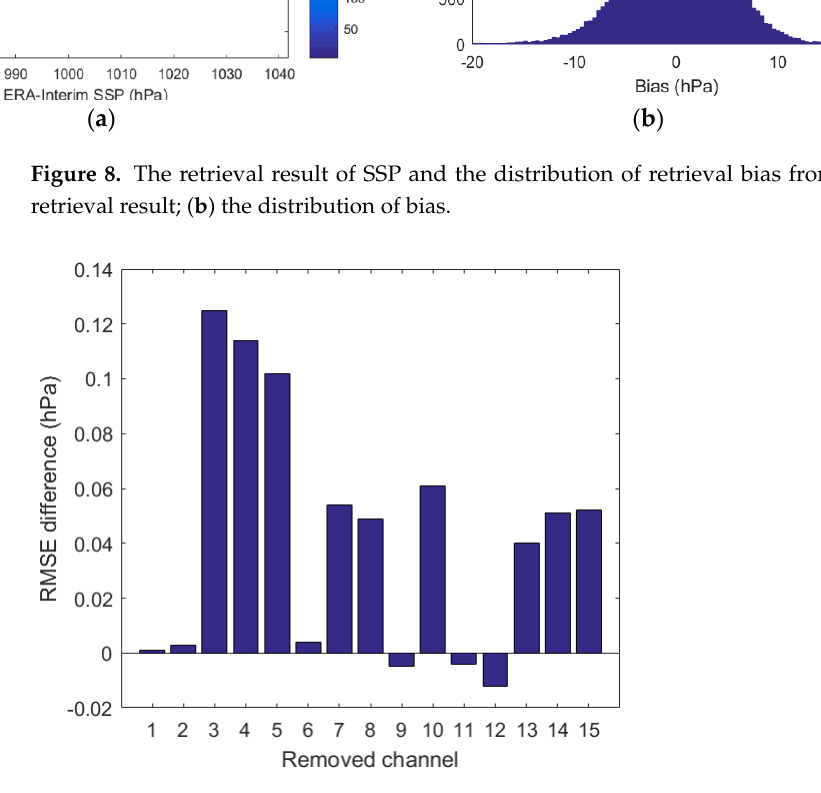
Figure 9. The differences between the SSP retrieval accuracy from MWHTS and the 15 SSP retrieval accuracies from the MWHTS channel combination removing one channel.